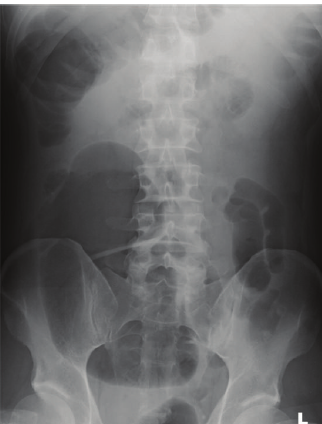
Figure 3: CT scan of chest (coronal section) showing bilateral cavitating lesions in the lung apices (indicated by arrows).